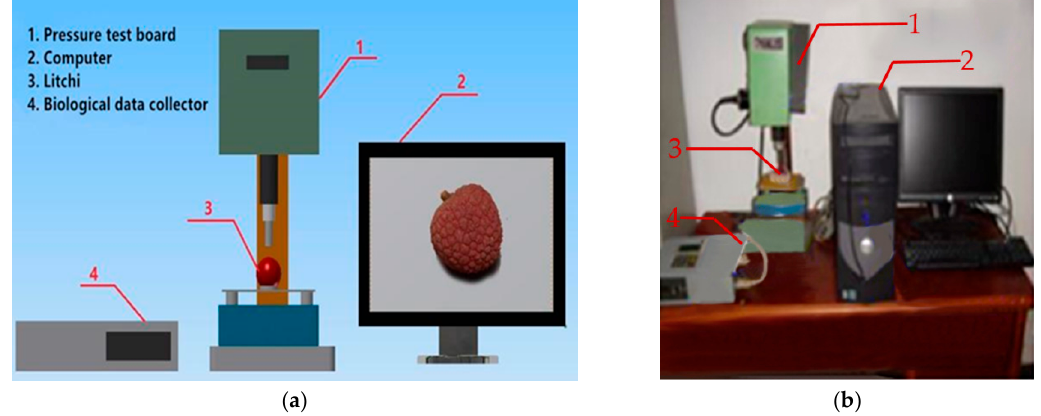
Figure 2. The test platform for data acquisition of litchi damage. ( a ) Sketch map, ( b ) Physical picture. Step